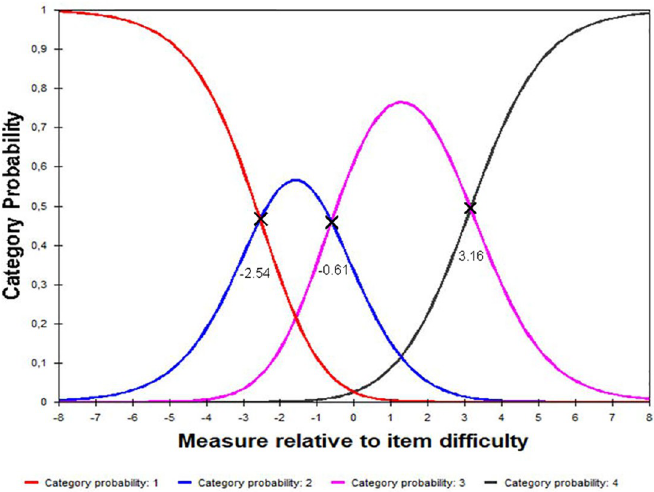
Fig 1. Rating scale category probability curve for the 9-items of Greek-language